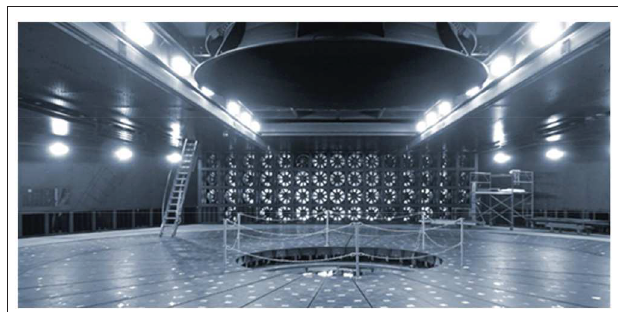
FIGURE 5 | WindEEE Dome test chamber (courtesy Professor Horia